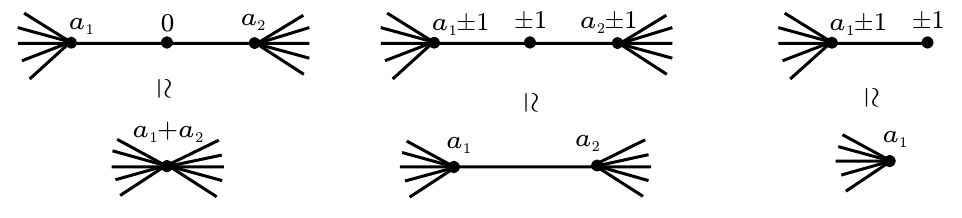
Figure 12 . 3d Kirby moves that relate plumbings giving homeomorphic